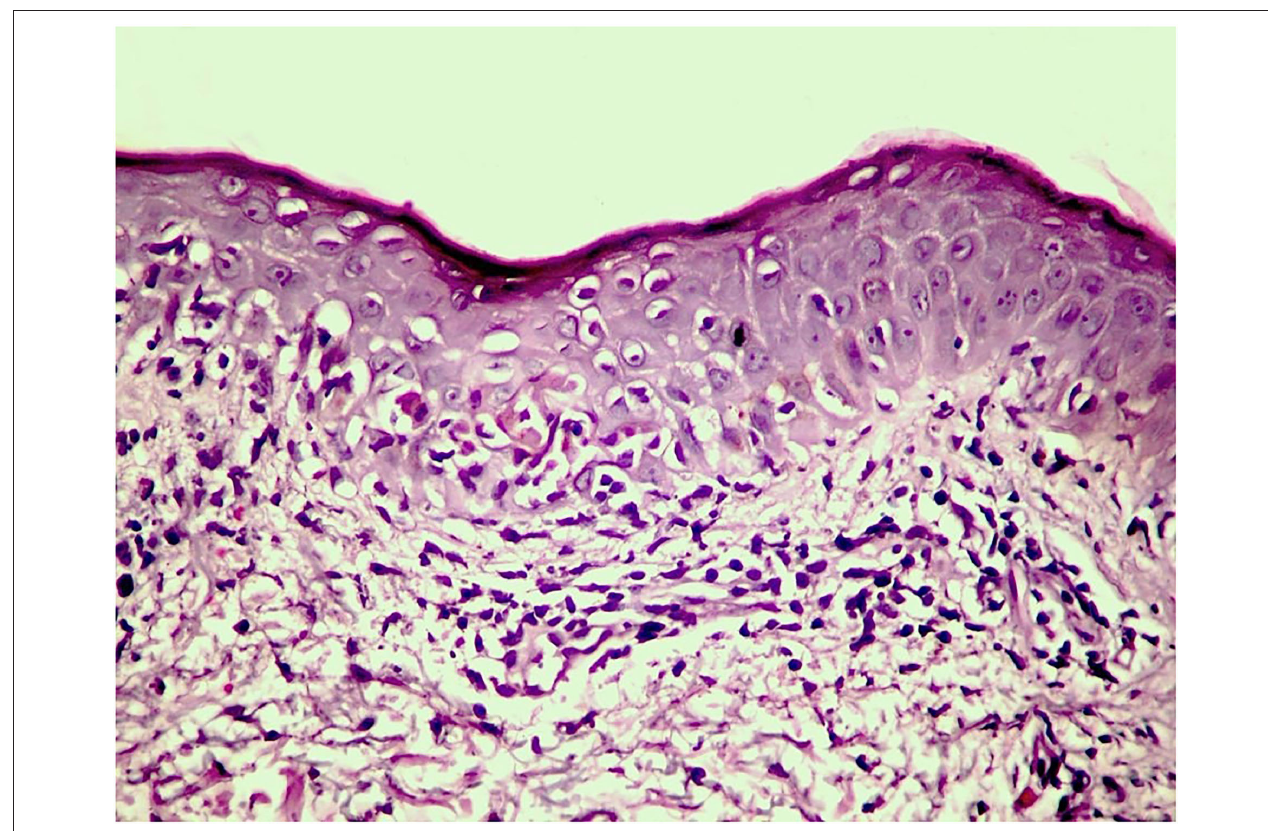
FIGURE 3 | Hematoxylin and eosin stain of a biopsy from the periphery of an annular lesion showing SCLE features: epidermal atrophy, interface dermatitis, and lymphohistiocytic dermal infiltrate.